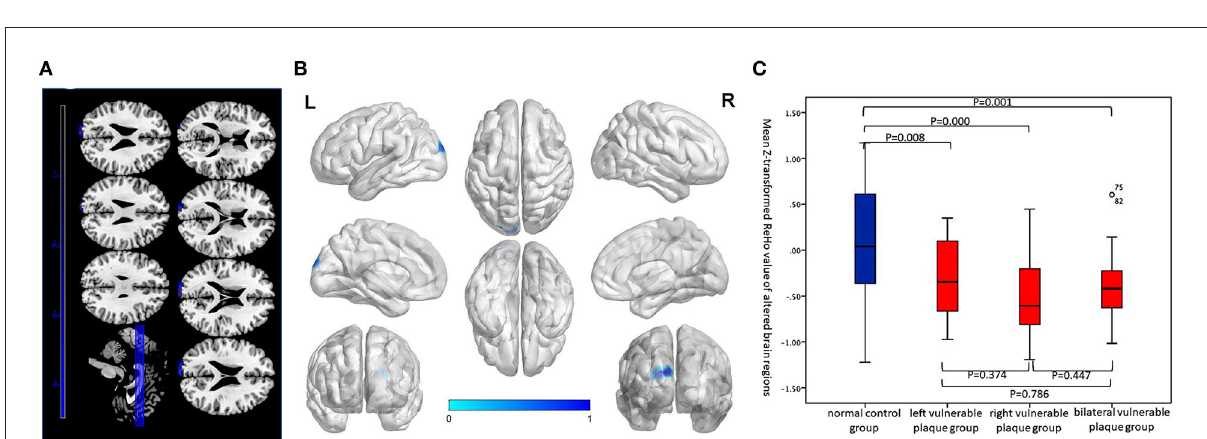
FIGURE1 (A,B) Compared with the normal control group, brain regions with abnormal resting-state ReHo in the asymptomatic vulnerable plaque group, mainly located in the SOG.L (cluster size 72, p < 0.05, FWE correction). (C) Brain regions with abnormal ReHo values were extracted for multiple comparisons among the normal control group, left asymptomatic vulnerable plaque group, right asymptomatic vulnerable plaque group, and bilateral asymptomatic vulnerable plaque group. Compared with the normal control group, the left, right, and bilateral vulnerable plaque groups showed significant differences; however, the ReHo in this area did not significantly differ among the left, right, and bilateral